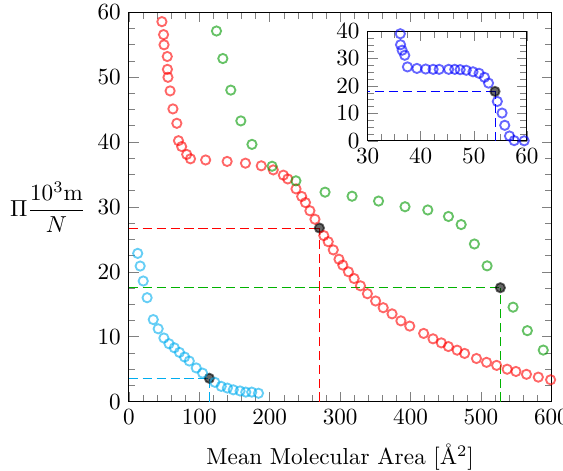
Figure 5. Four surface pressure-area isotherms are reproduced from previously reported studies: The red-colored data set is for cyclosporin A in the presence of 3 M NaCl, adopted from Figure 5 of Miñones et al. [21]. The lightblue-colored data set is for a monolayer of the antifungal drug nystatin, adopted from Figure 1 of H ˛ac-Wydro and Dynarowicz-Ł ˛atka [24]. The green-colored data set is for a monolayer composed of the synthetic alpha-helical lipopeptide BBC16, adopted from Figure 1 of Strzalka et al. [35]. The blue-colored data set shown in the inset is for 7 α -hydroxycholesterol, adopted from Figure 2A of Wn˛etrzak et al. [27]. For all four isotherms, we have marked the relevant point of inflection with a filled black